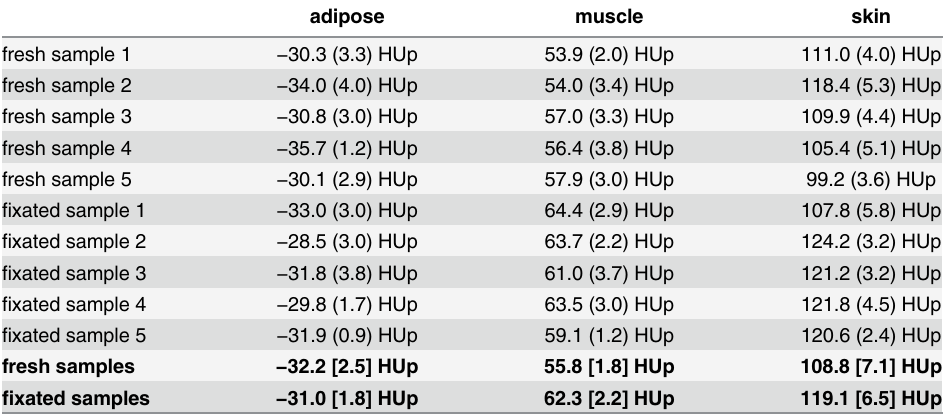
Table 1. HUp values of five non-fixated (fresh) and five fixated (3.7% formaldehyde solution) tissue samples containing adipose tissue, muscle tissue and skin. The numbers in regular typeface represent the mean values and standard deviations (round brackets) obtained from ten regions-of-interest that were analysed for each of the three tissue types and each individual sample. The bold numbers finally give the mean values and standard deviations (square brackets) of these individual results and reflect the differences in the tissues ’ HUp in non-fixated and fixated state. adipose